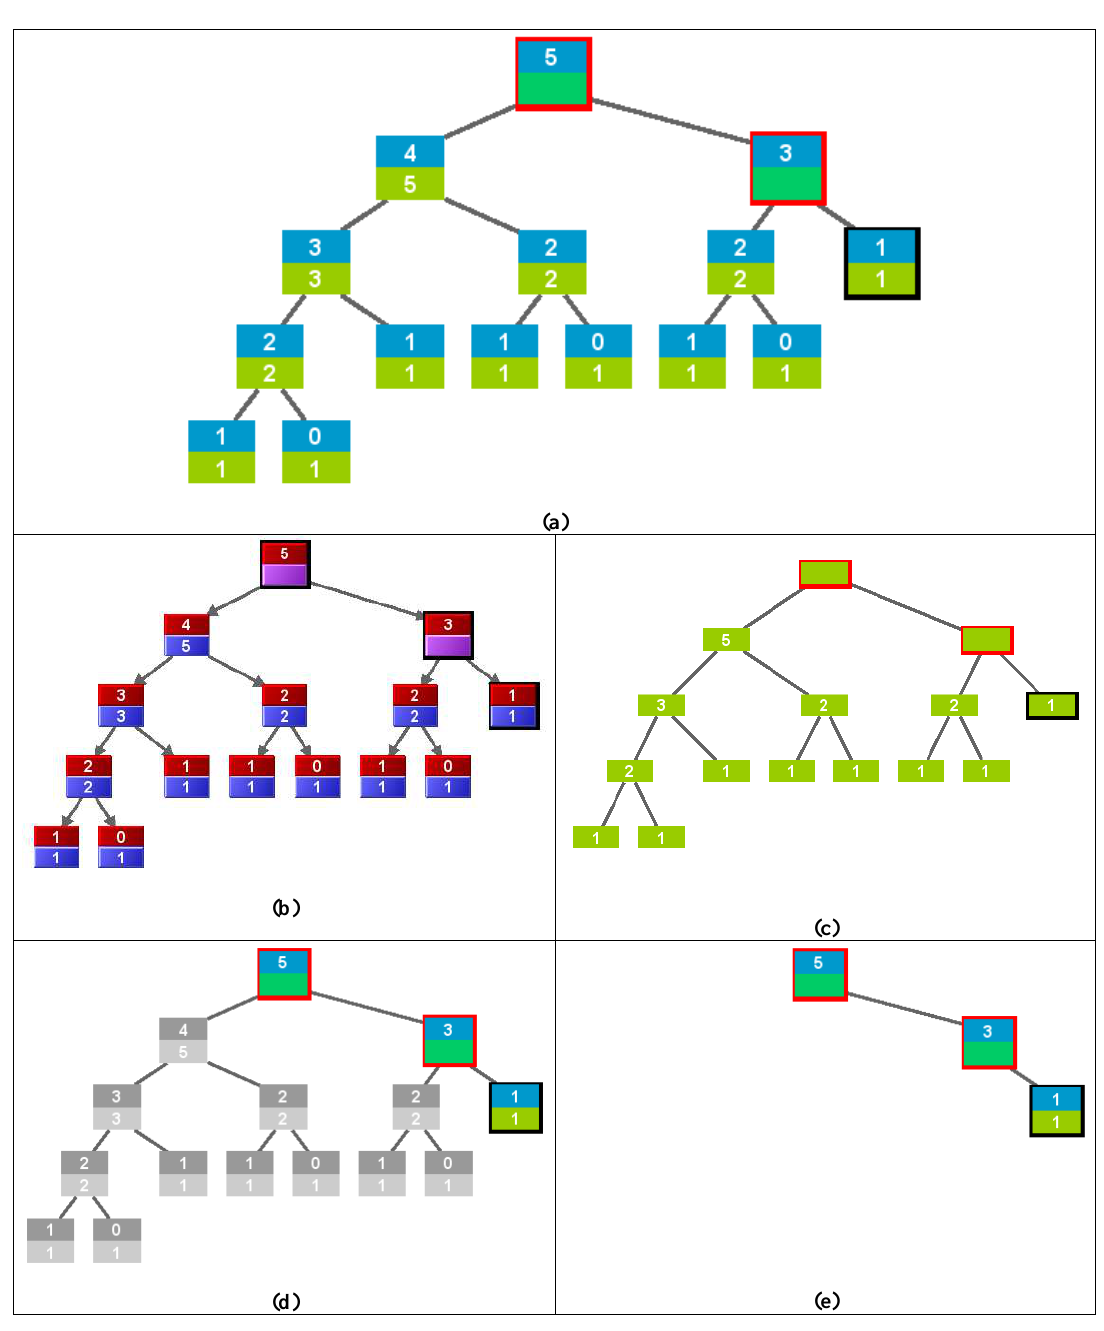
Figure 3. Recursion tree for fib (5): (a) basic visualization (b–e)